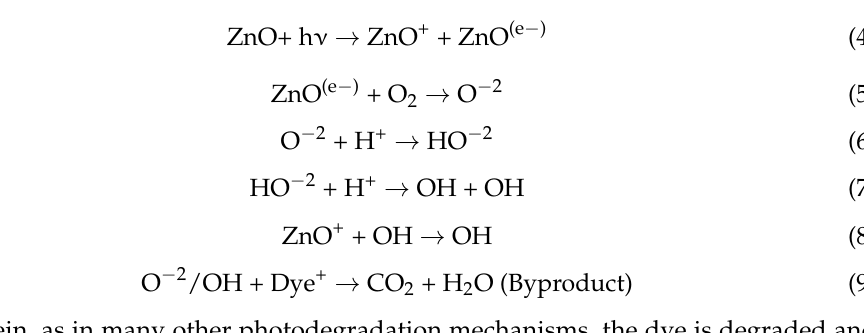
Figure 10. Photocatalytical activity of Honey-mediated ZnO nanoparticles against phenol.